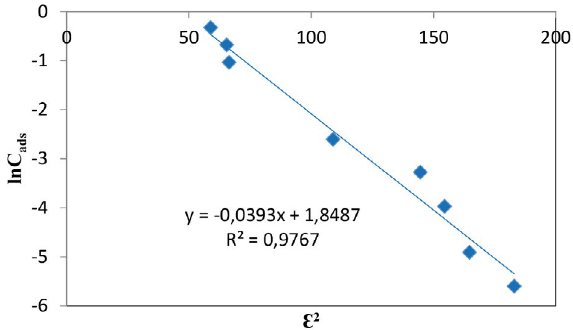
Figure 12. Dubinin-Raushkevich isotherm for Cr(VI) sorption onto isatin based Amberlite XAD-2 resin Table 3. Isotherm parameters for Cr(VI) sorption on Isatin based Amberlite XAD-2 resin